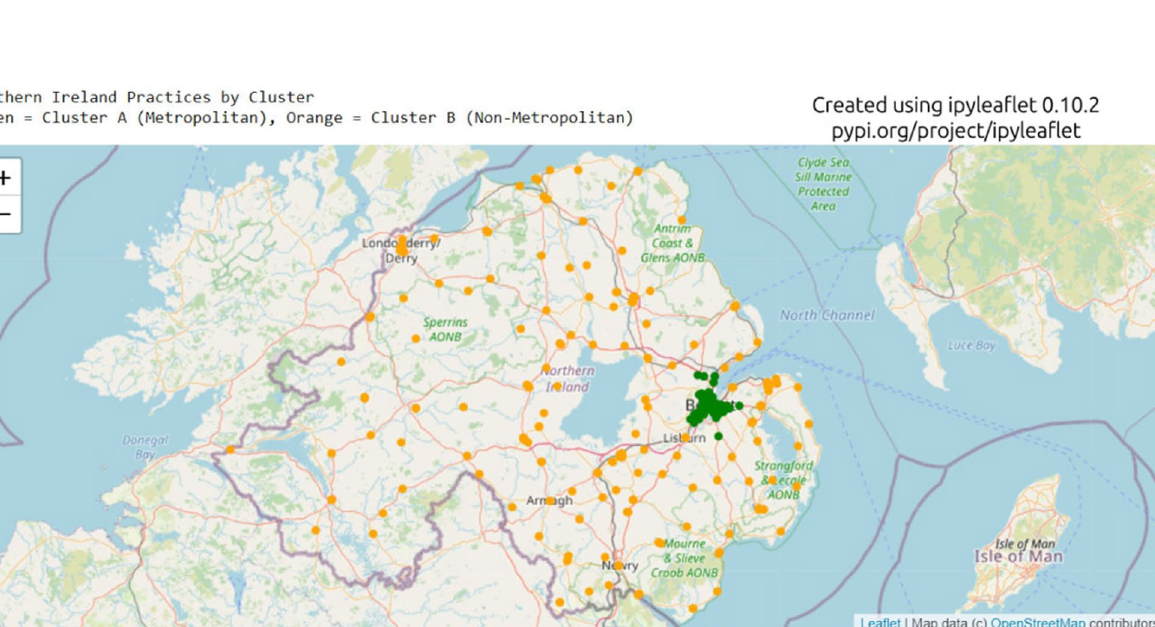
Table 2. Clusters identified and shown geographically in Fig. 4.